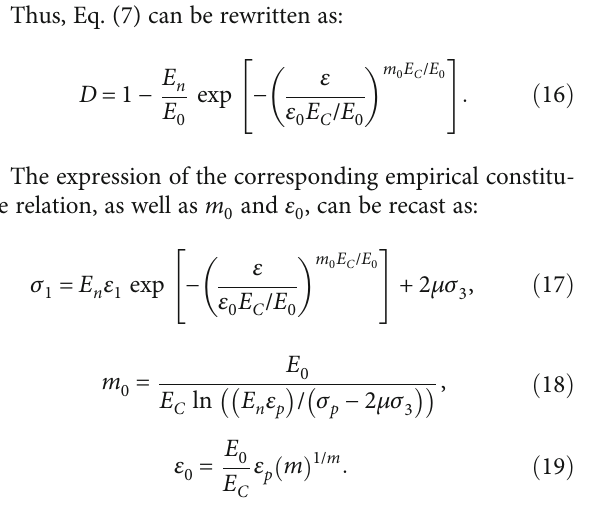
Table 3: The values of m